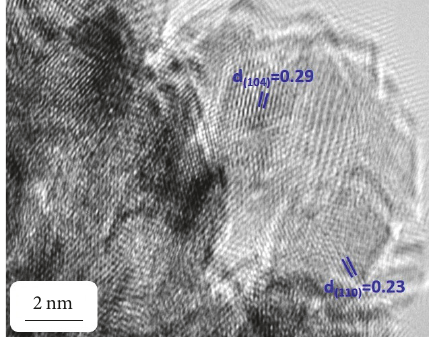
–MnCO 3 nanocomposite. x